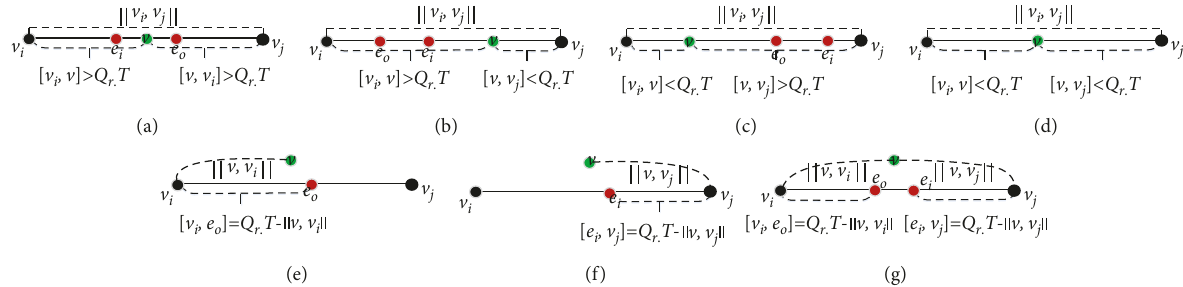
Figure 9: Illustration of range event point computation. (a) Event point 1. (b) Event point 2. (c) Event point 3. (d) Event point 4. (e) Event point 5. (f) Event point 6. (g) Event point